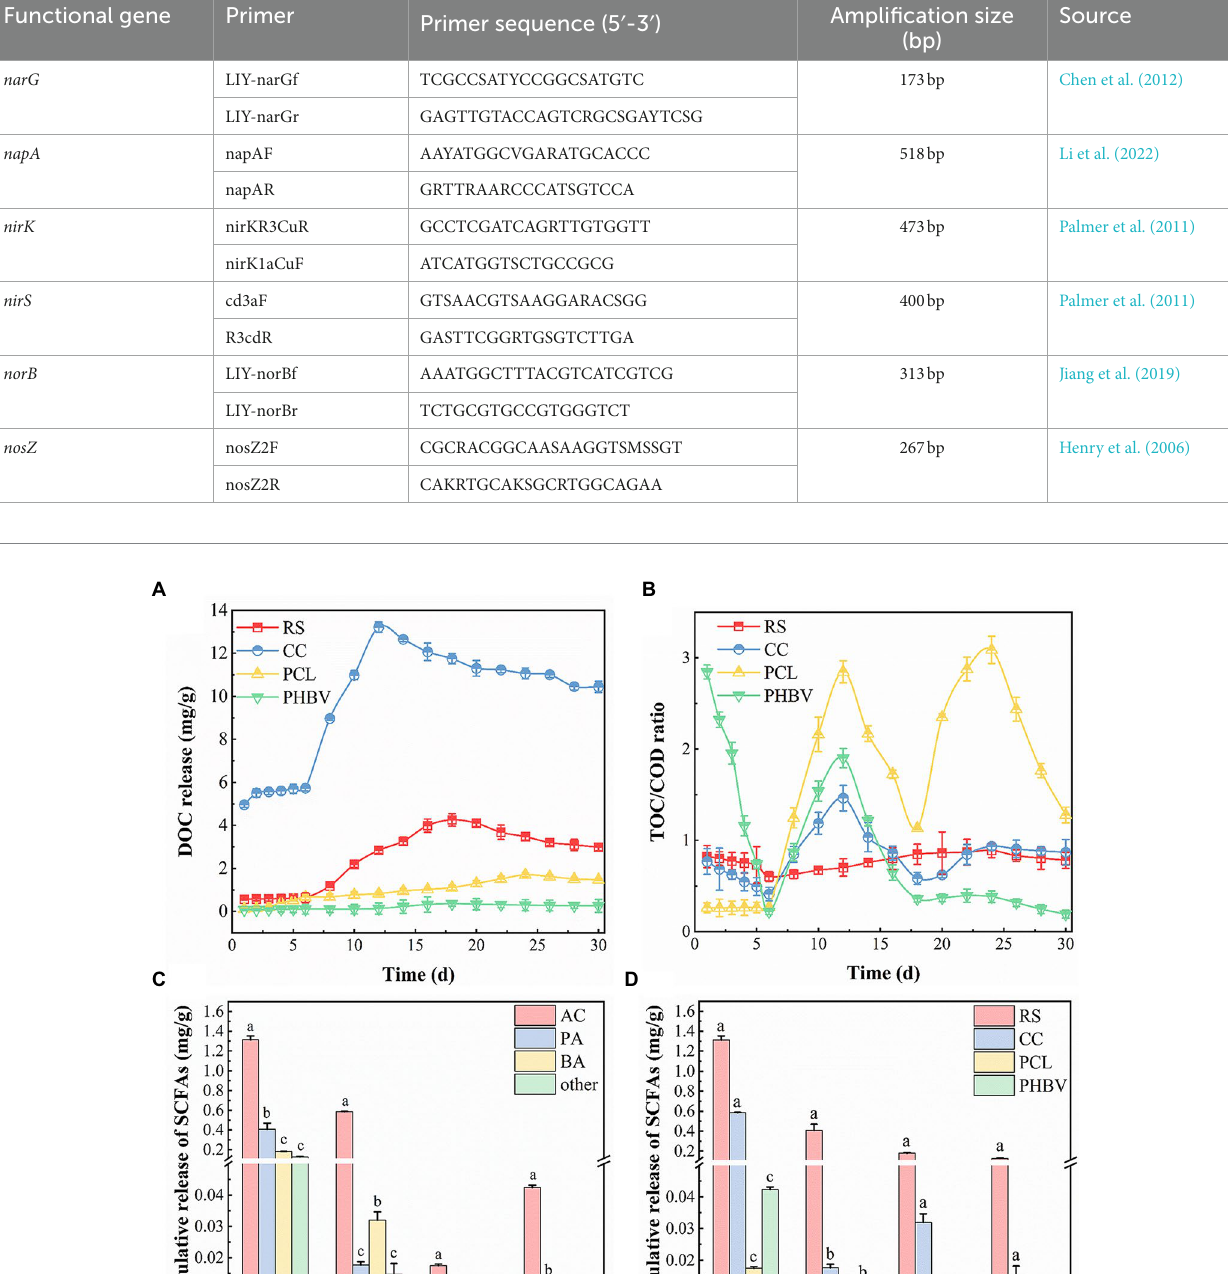
TABLE 2 Primers for quantitative real-time PCR assays.